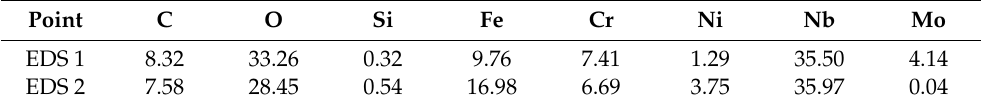
Figure 4. Surface SEM images of samples S1 ( a , b ) and S2 ( c , d ) oxidized in CO 2 at 650 °C under 3.5 MPa for 500 h ( a , c ) and 1000 h ( b , d ), respectively. Table 2. EDS results (wt.%) of the micro-zones marked in Figure 4.